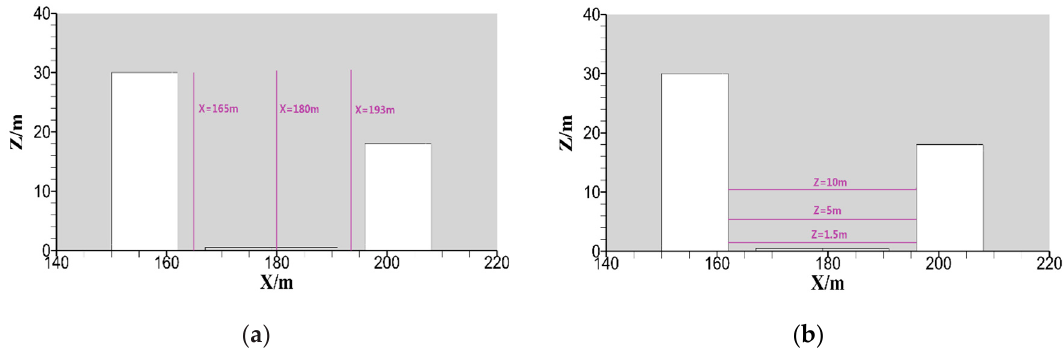
Figure 10. Selected line diagram of vertical and horizontal directions in the Y = 160 m section. ( a ) Vertical direction; ( b ) Horizontal direction.